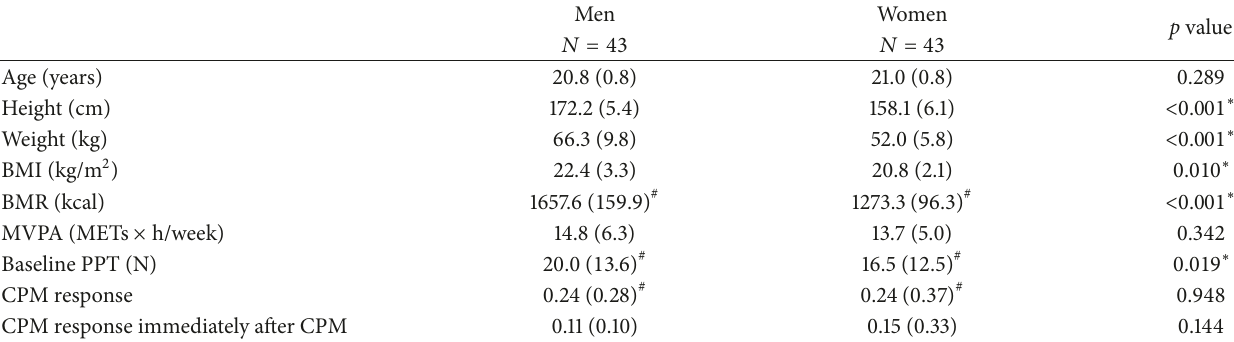
Table 1: Sex-wise differences in characteristics of the study participants.